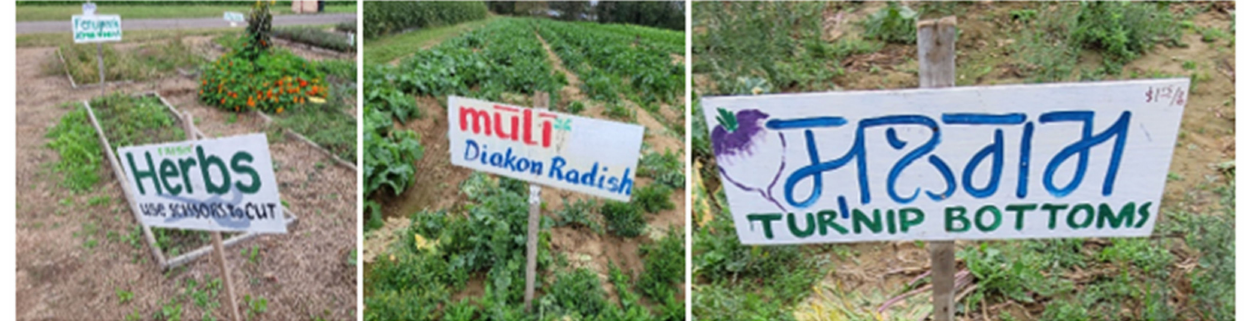
Figure 4. Examples of plot identification at Specca Farm Pick-Your-Own for effective communication of plot content to a diverse pool of Pick-Your-Own customers.